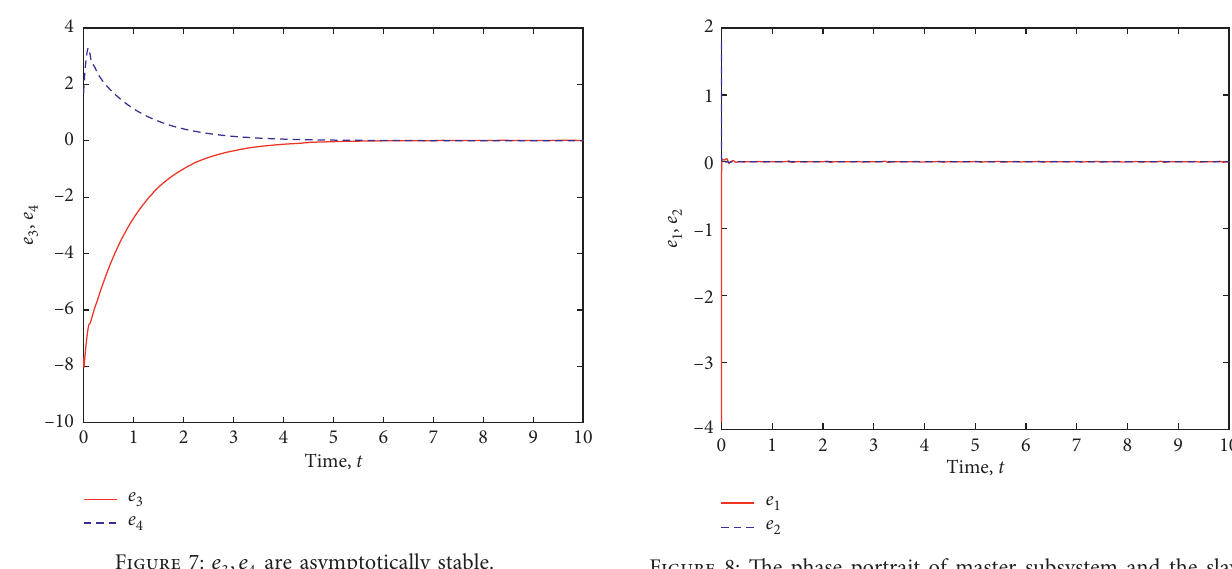
, e are asymptotically stable. 1 2